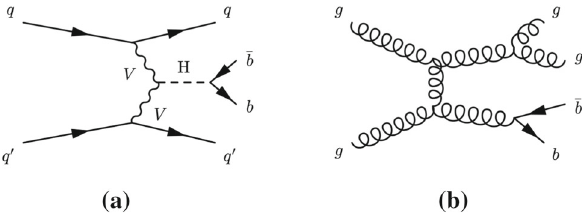
Fig. 1 Feynman diagrams of a the VBF signal process and b gluon splitting as an example background